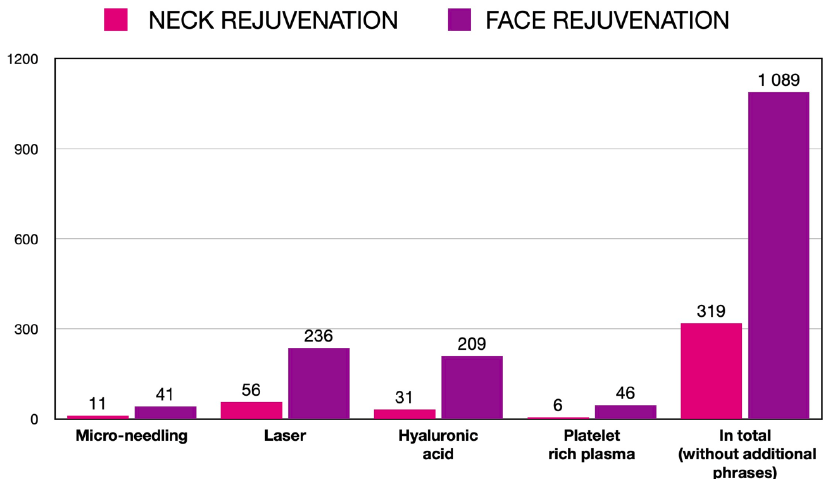
Figure 1. Number of PubMed hits for micro-needling, laser, hyaluronic acid, and platelet-rich plasma by the area of rejuvenation.